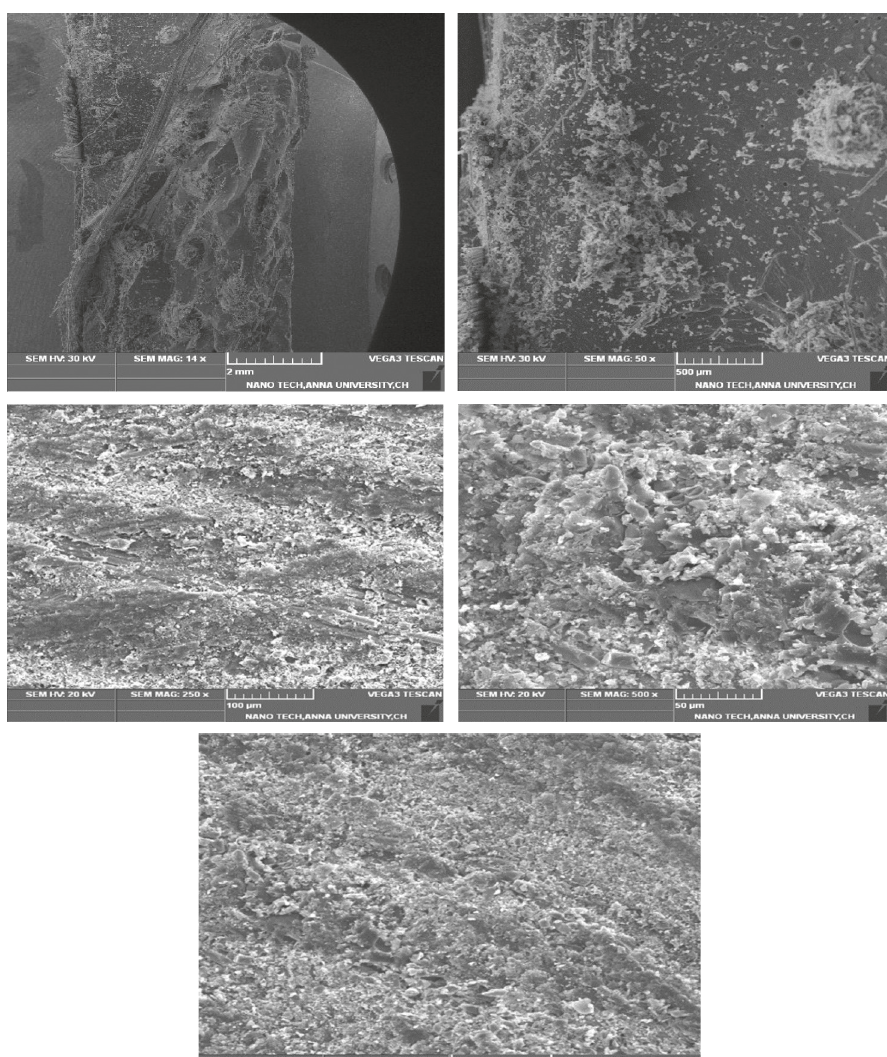
Figure 5: Tensile failure